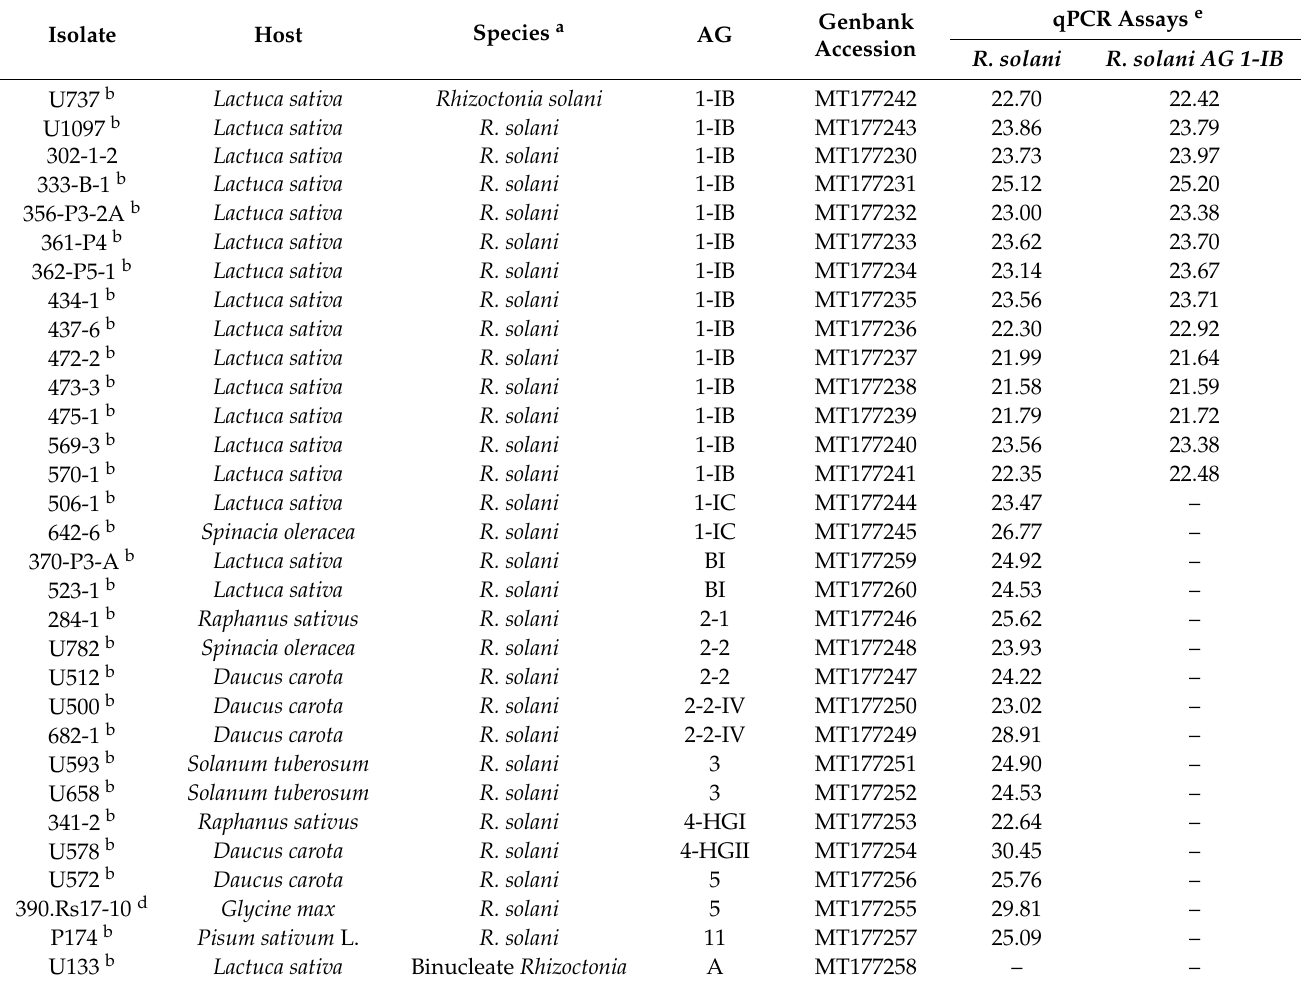
Table 1. Isolates of Rhizoctonia solani, Binucleate Rhizoctonia, and other pathogens used to test the specificity of the R. solani and R. solani AG 1-IB qPCR